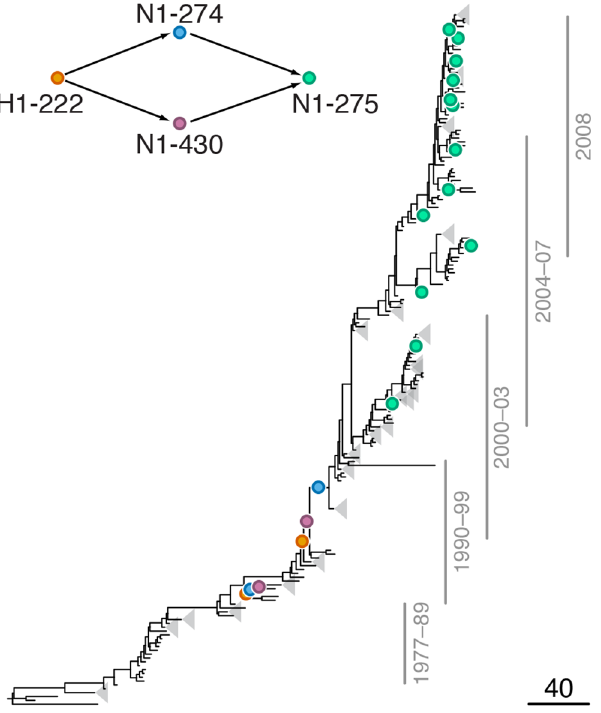
Fig 3. Example of putative inter-gene epistasis between sites H1-222 and N1-274. Mutations at sites H1- 222 and N1-274 are marked by orange and blue circles, respectively; mutations at site N1-275 are marked by green circles. Site N1-275 was found to form a highly scoring inter-gene epistatic pair with site N1-274 in our previous study [21] (see text for details). Only mutations that form consecutive pairs are shown (see Materials and Methods); see S2 Data for all mutations. Vertical bars show years in which the isolates where sampled. The inset shows the inferred directionality of epistatic interactions with arrows pointing from the leading to the trailing